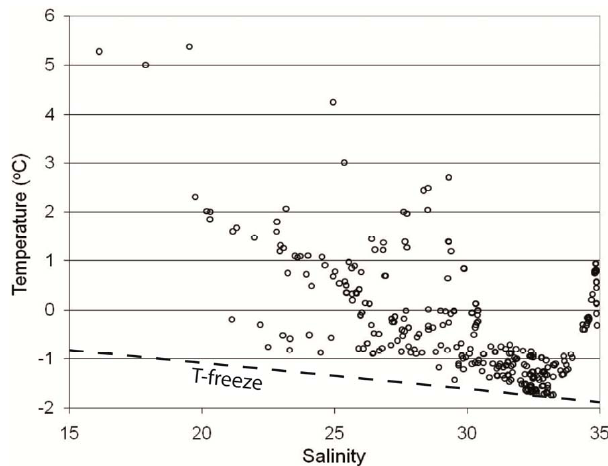
Fig. 5. Plot of temperature versus salinity. The freezing temperature as a function of salinity is illustrated by the dotted line.